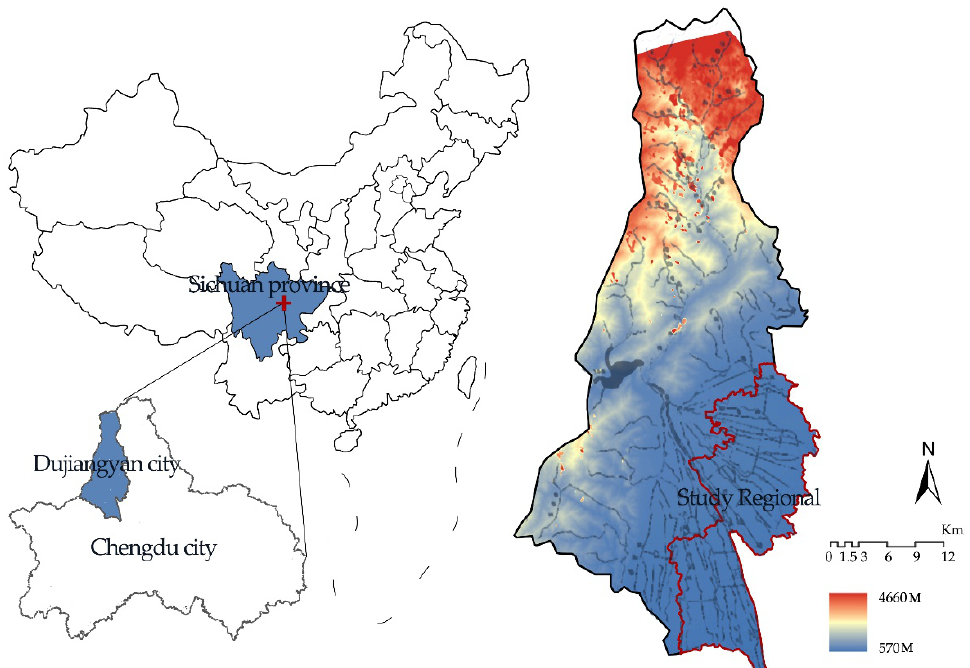
Figure 2. Geographical location of the Dujiangyan Irrigation District.